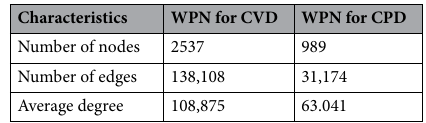
Table 2. Characteristics of the patient